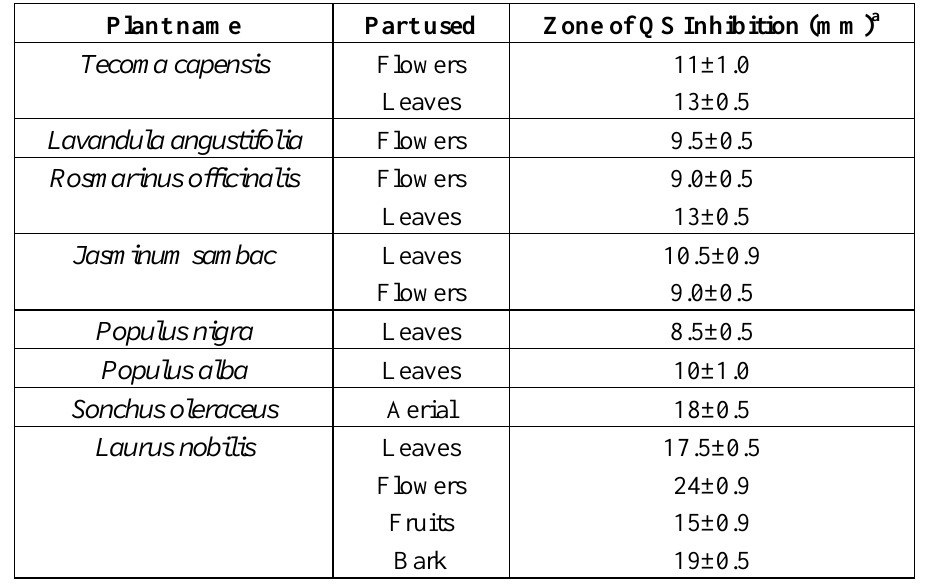
Table 3. Diameter (mm) of antiquorum sensing activity of different ethanolic plants extracts at the concentration of 3 mg per disc. Tetracycline at 30 µg/disc was used as a positive control of total microbial growth inhibition.